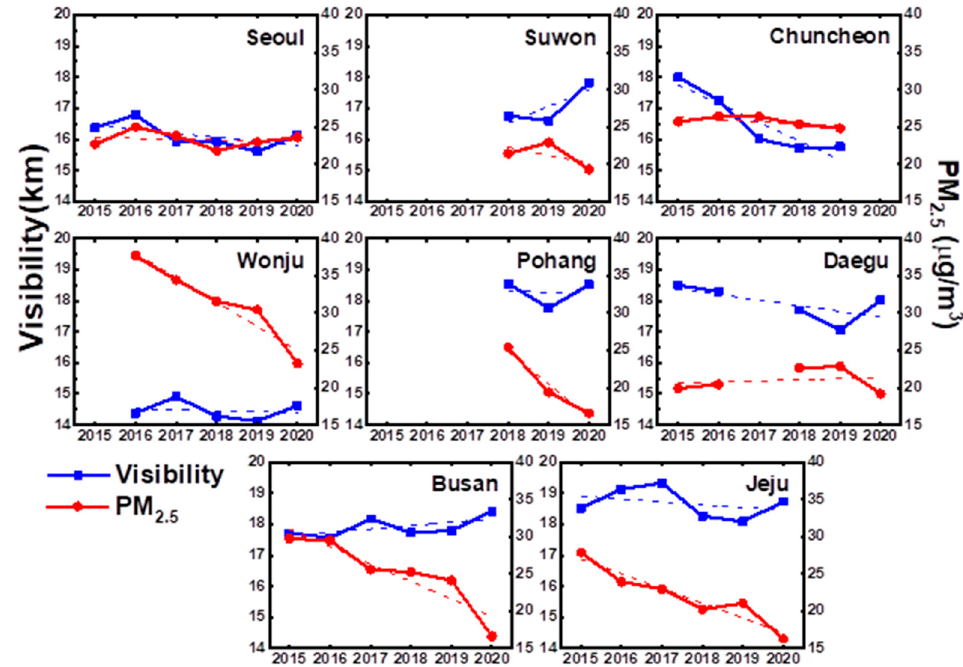
Figure 3. Eight cities’ annual average and trend in visibility and PM 2.5 in 2015–2020. Table 3. MK Test and Sen’s slope for visibility, PM 2.5 and Q e,2.5 annual trend 2015–2020 (clear trend with 95% confidence level for |z| > 1.96 and 99% confidence level for |z| > 2.57). There were few data available for analysis of annual trends for Suwon and Pohang. Visibility